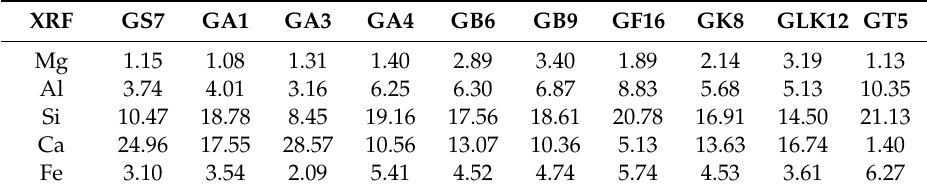
Table 5. XRF analysis of samples (% w / w